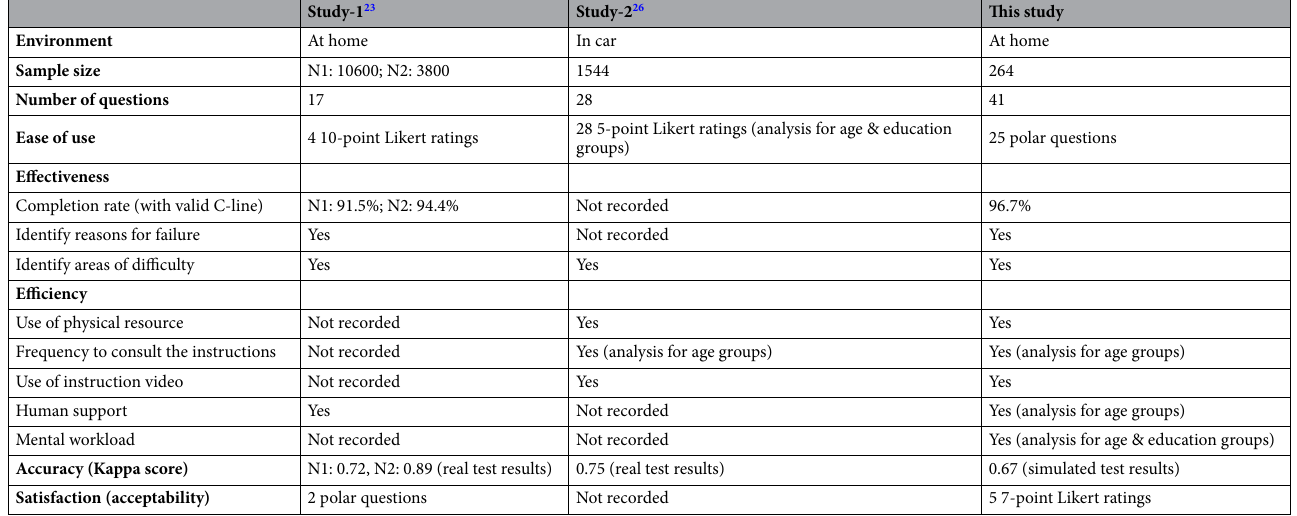
Table 9. Comparison of UX analysis methods used in this study and two related studies for LFIA self-testing for